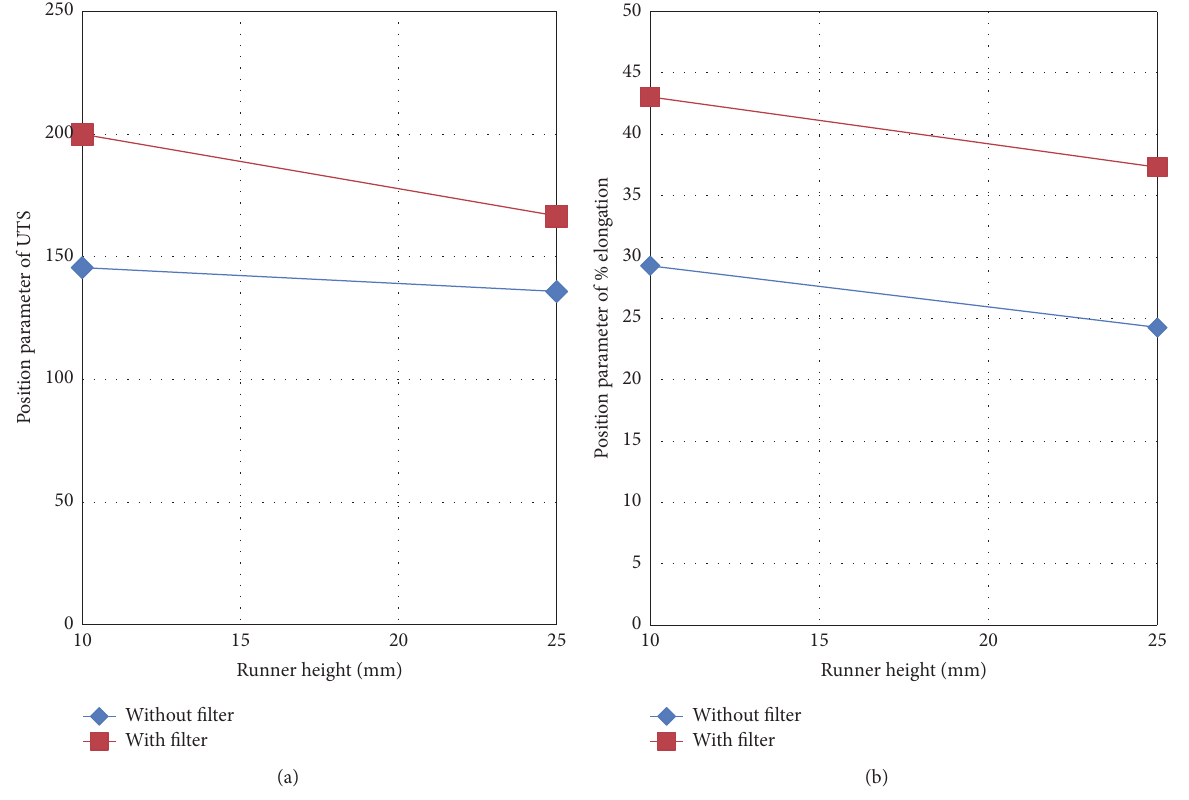
Figure 5: Plot of runner height versus (a) position parameter of UTS and (b) position parameter of % elongation.